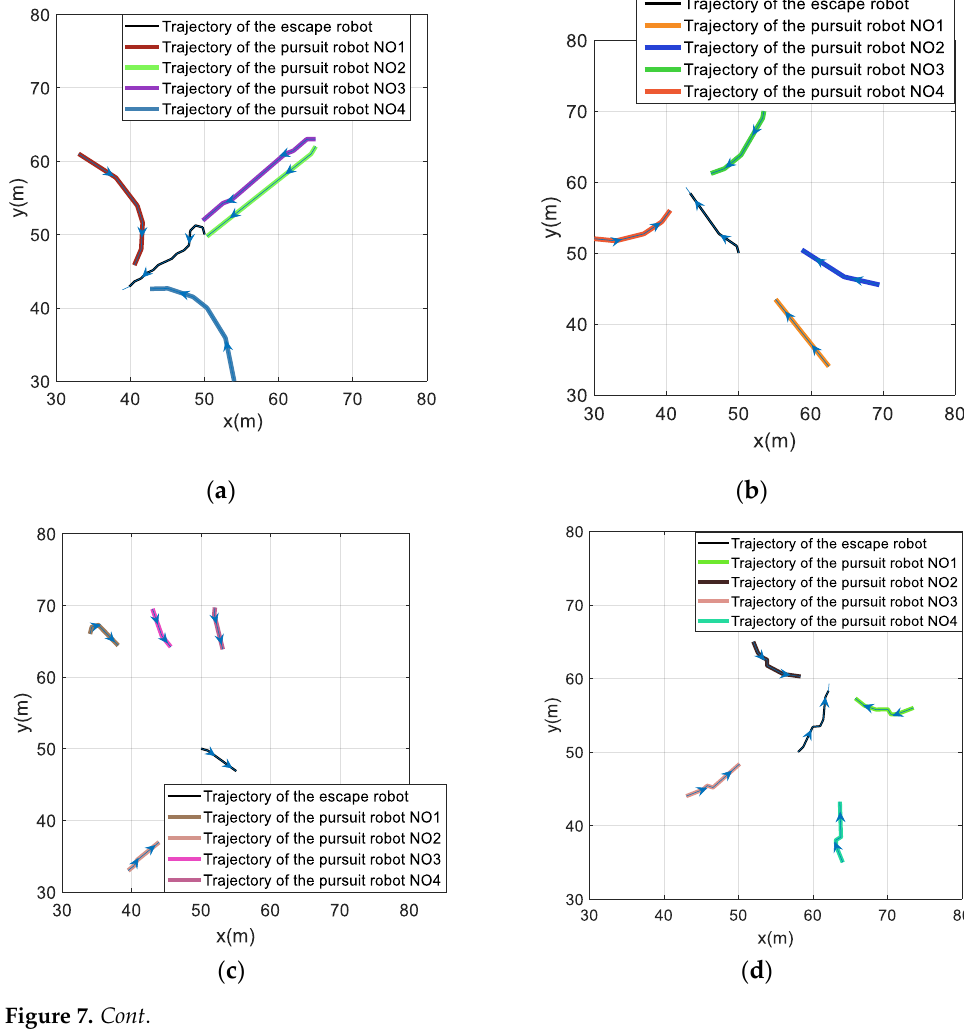
( e ) Figure 7. Pursuit robot team pursuit of the escape robot with different speeds: ( a )  P V 1m/s , and failed capture. Figure 7a,b,d show the movement trajectory of each pursuit robot and the escape robot when the task is completed successfully. Figure 7c,e show the movement trajectories of the robots when the task fails. Through the comprehensive analysis of the above simulation results, it can be seen that when the pursuit robots move faster than the escape robot, the pursuit robots can always capture the escape robot with their speed advantage In addition, from the trajec- tories of Pursuit Robots 2 and 3 in Figure 7a, we know that since the initial positions of Pursuit Robots 2 and 3 are very close, it is a dangerous situation for the pursuit robots. However, under the effect of the collision avoidance term of the payoff function, the pur- suit robots adopted a collision-avoidance movement strategy at the initial stage of the pursuit, which increased the distance between Pursuit Robots 2 and 3 and avoided a col- lision between the pursuit robots. From the simulation results of the successful pursuit tasks in Figure 7b,d, we know that when the escape robot is faster, the pursuit robots maintain the surrounding state of the escape robot through cooperation and gradually shorten the shortest distance between the pursuit robots and the escape robot until the capture conditions are met and the escape robot is captured. It is verified that the multi- robot game pursuit model established in this paper can fully exert the advantage of the cooperative relationship between the pursuit robots. From the simulation results of the failed pursuit tasks in Figure 7c,e, we know that an unreasonable position distribution of